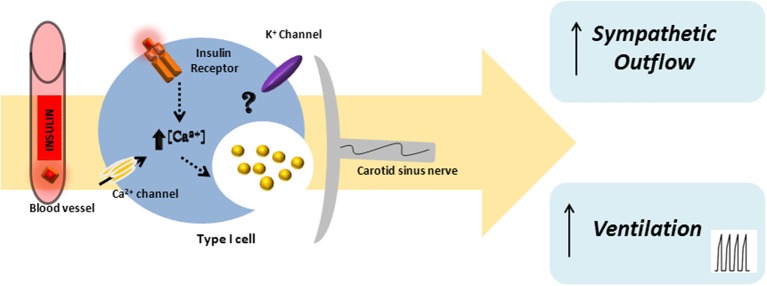
Schematic representation of insulin action in the carotid body. Insulin will act on insulin receptors present in the carotid body chemoreceptor cells eliciting an increase in intracellular Ca2+ and the release of neurotransmitters, such as dopamine and ATP. The insulin-induced neurosecretory response in chemoreceptor cells is transduced in an increase in ventilation and in an augmented sympathetic outflow.